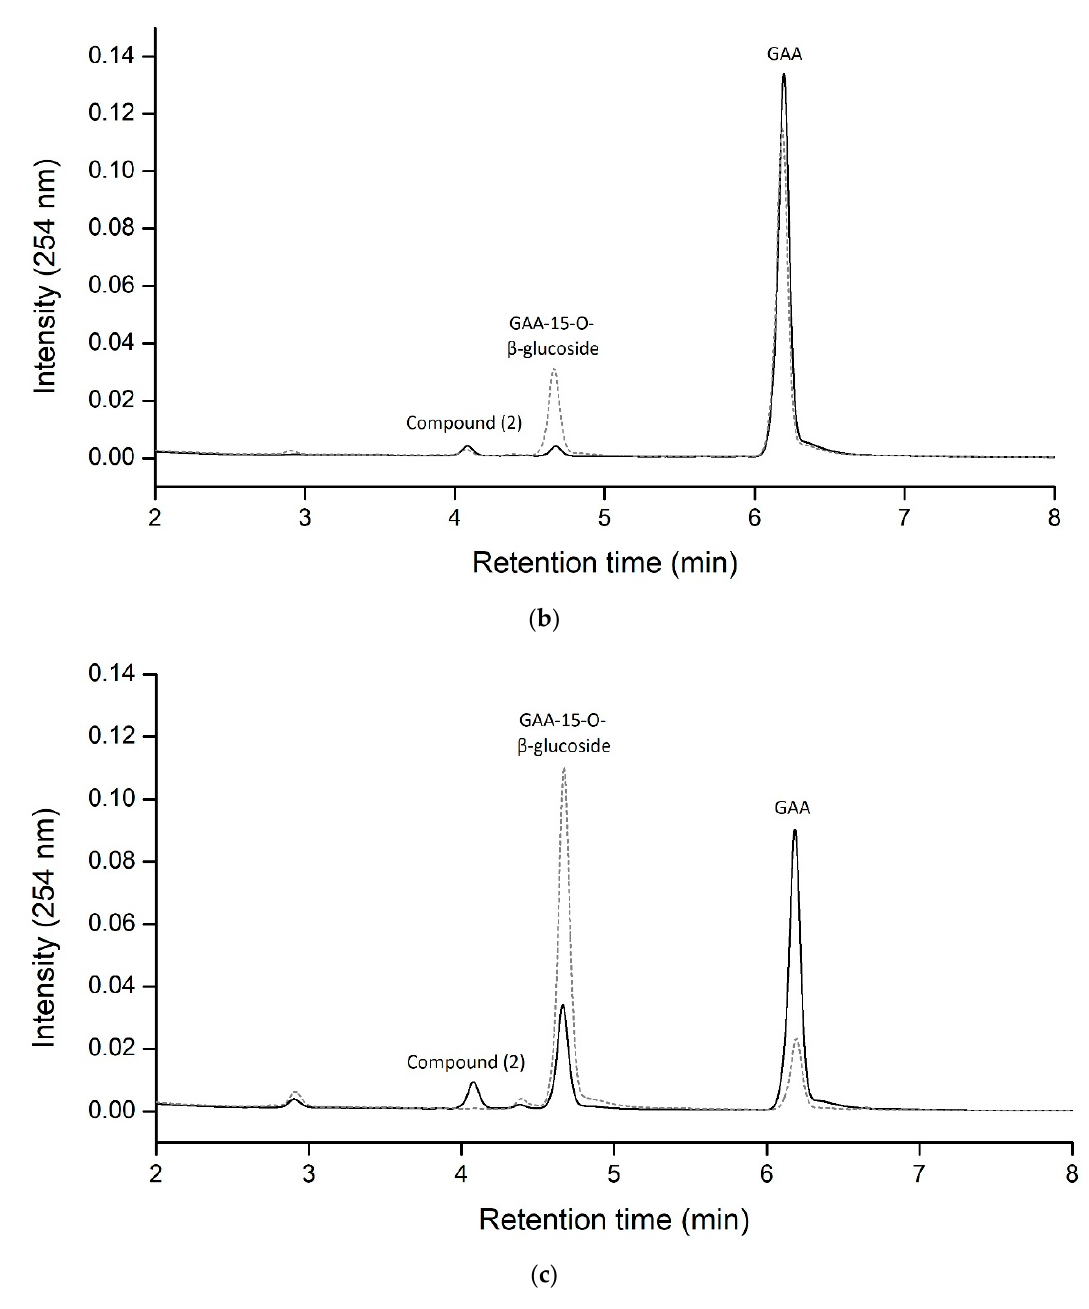
Figure 2. Ultra-performance liquid chromatography (UPLC) analysis of the biotransformation of GAA by BsGT110 ( a ), BsUGT398 ( b ), and BsUGT489 ( c ) at pH 6 (solid line) and pH 8 (dashed line). The biotransformation mixture contained 15 μ g/mL purified enzyme, 1 mg/mL GAA, 10 mM uridine diphosphate (UDP)-glucose, 10 mM MgCl 2 , and 50 mM acetate buffer at pH 6 or phosphate buffer (PB) at pH 8 and was incubated at 40 °C for 30 min. After incubation, the reaction was analyzed using UPLC. The UPLC operation procedure was described in the Materials and Methods section. Table 1. Relative production a of GAA-15- O - β -glucoside and compound ( 2 ) catalyzed from GAA by BsGT110.